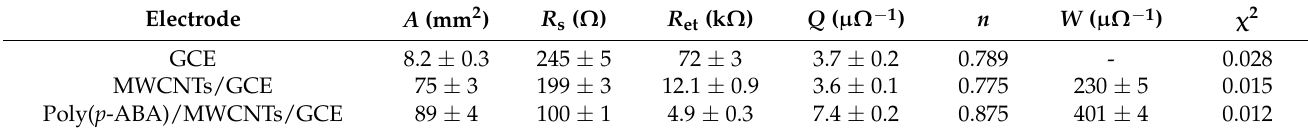
Table 1. Electroactive surface area and fitted parameters of the electrochemical impedance for the electrodes ( n = 5; p = 0.95).